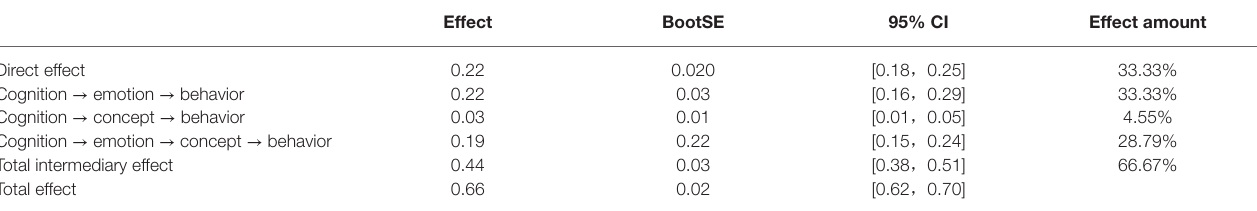
TABLE 5 | Intermediary effect